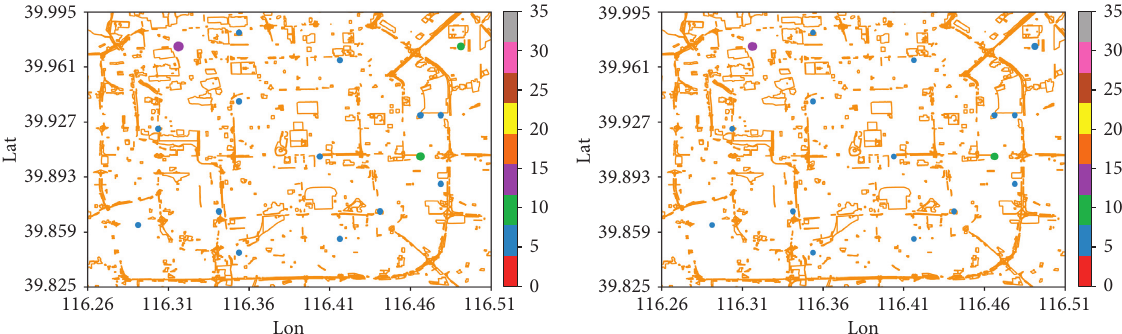
Figure 13: Parking spots and vehicle distribution when rate � 0.5.